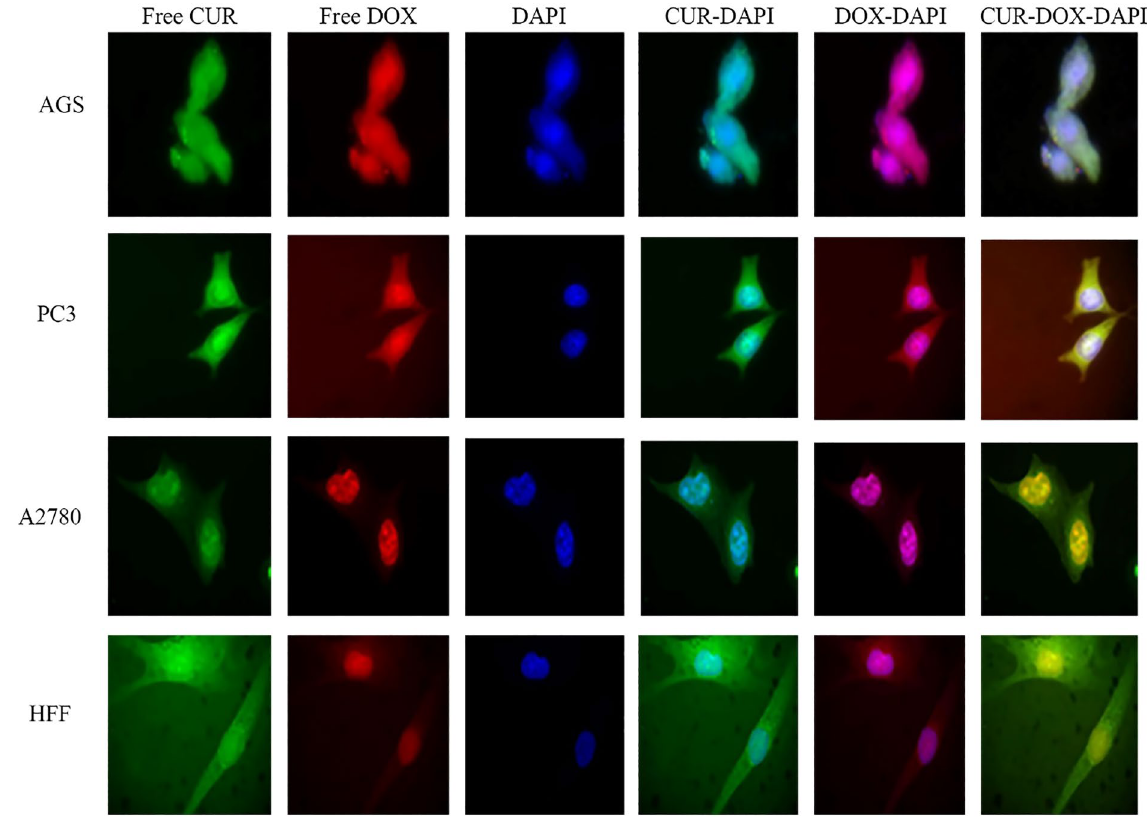
Figure 5. Cellular uptake images of AGS, PC3, A2780 and HFF cells incubated with FREE CUR-DOX for 180